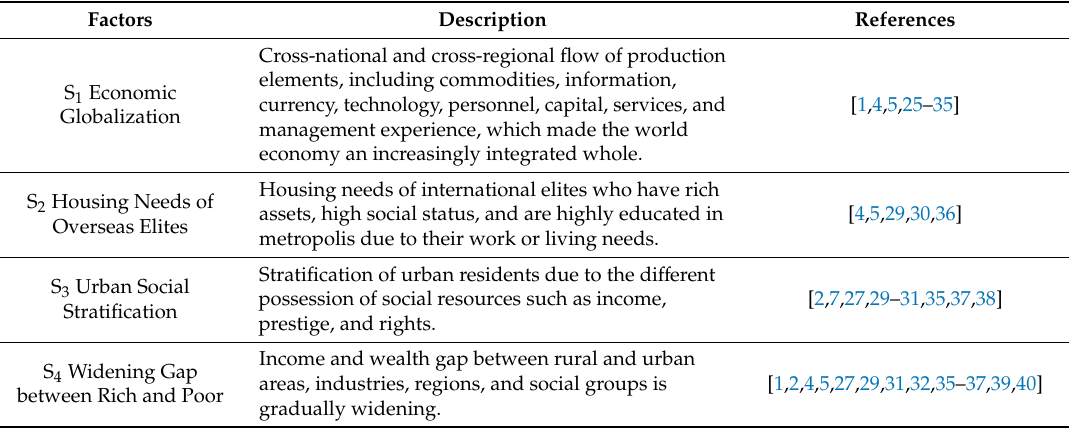
Table 1. Super-gentrification dynamic factors and their